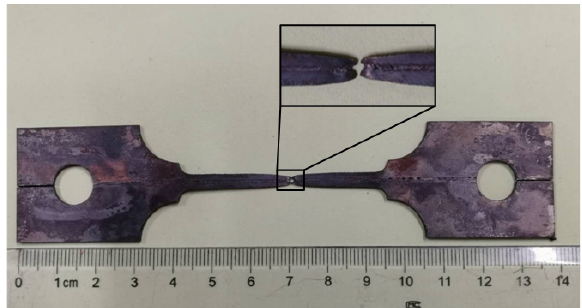
Figure 13. Fracture sample after tensile at high temperature.